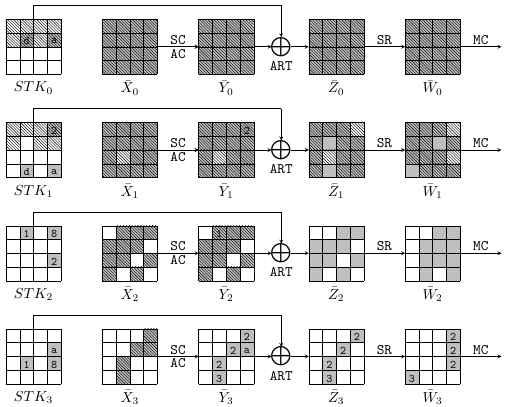
Figure 6: Phase (2): The N b -round of the attack on SKINNY-64-192